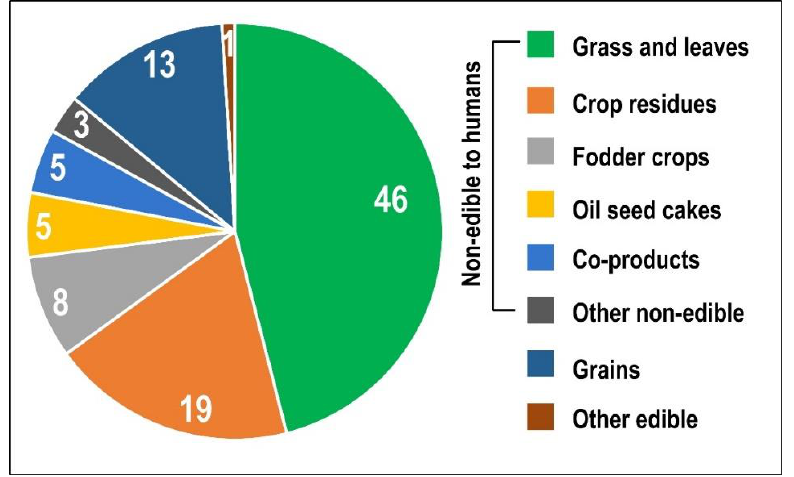
Figure 1. Distribution (%) of global livestock feed dry matter intake (adapted from [35]).